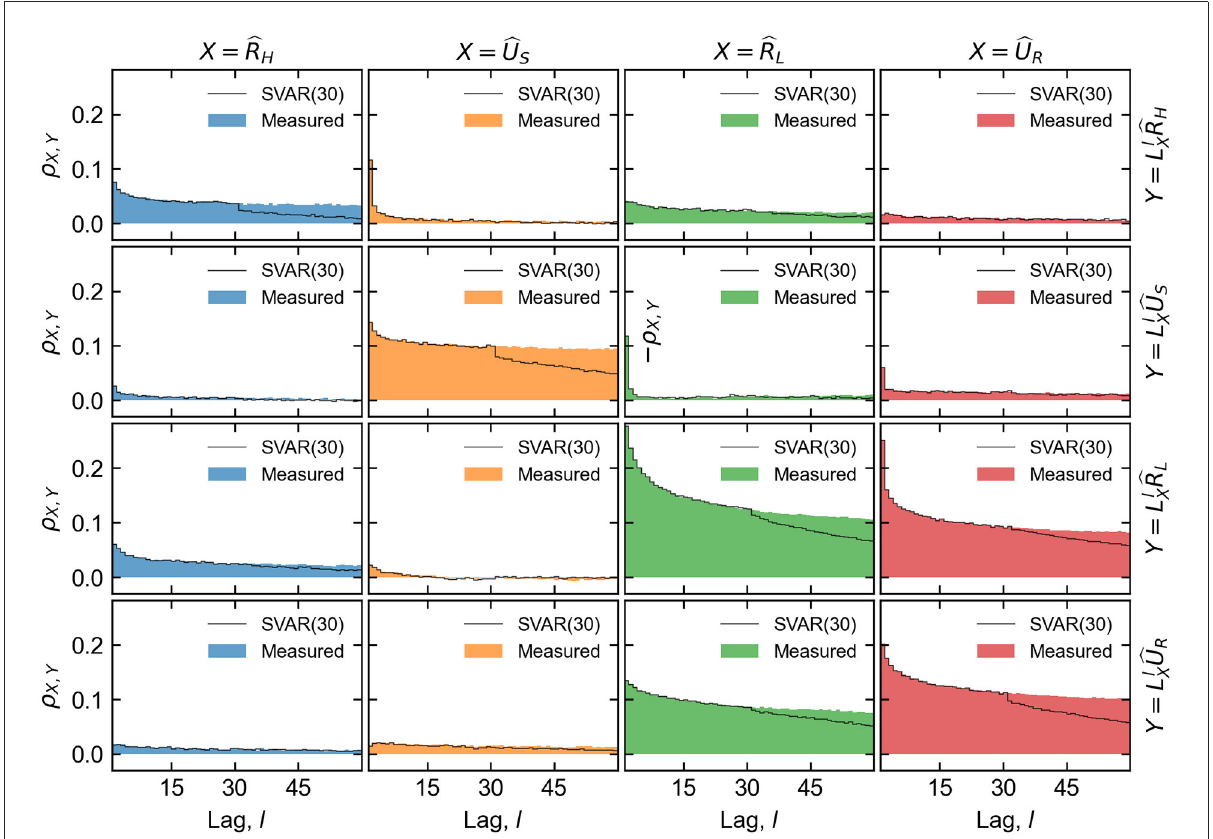
FIGURE14 Auto- and cross-correlations of the normalized feature vector components, showing the Pearson coefficients ρ X , Y of the variables specified in the subplot columns X and rows Y as a function of lag l . Row variables are lagged with respect to column variables, as denoted by the lag operators L X . A comparison between measurement data and data generated from SVAR(30) shows extremely close agreement up to cycle range 30. For lags larger than the chosen model order, some of the correlations of